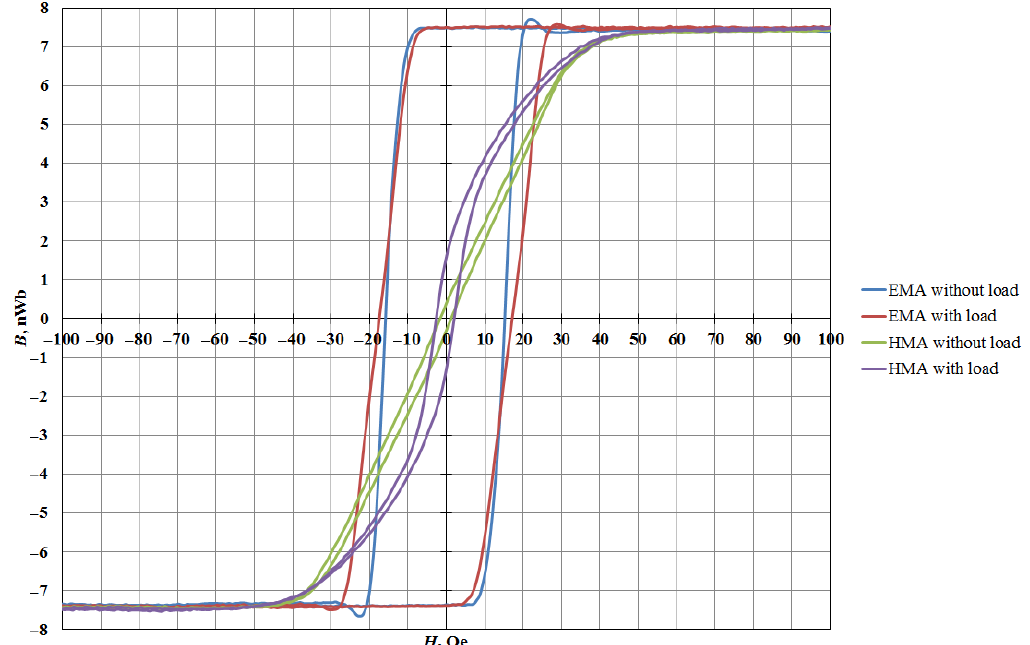
Figure 3. Dependence of B ( H ) in nanostructure Ta (5 nm)/FeNiCo (30 nm)/CoFe (10 nm)/Ta (5 nm) with and without mechanical load.